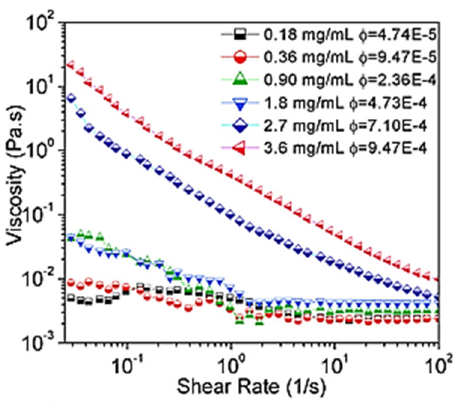
Figure 8. Variation of the viscosity of single-layer MXene flake as function of shear rate and with concentration ranging from 0.18 to 3.6 mg/mL [32]. Copyright 2018 American Chemical Society.